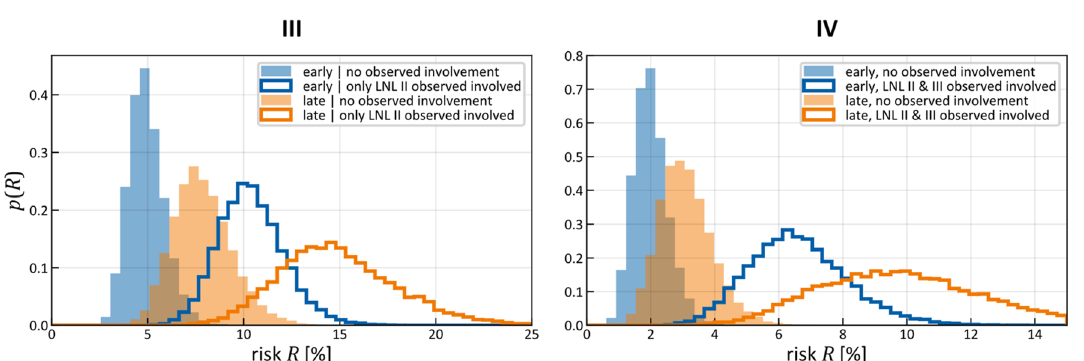
Figure 11. Distributions over risk of involvement for LNL III (left) and LNL IV (right), each for early and late T-category as well as depending on the given observed involvement. The sampled parameters displayed here are a randomly selected subset (1% of 200,000) from simultaneous learning. Comparison with Fig. 8 shows that these predictions still agree with the results from the early stage only